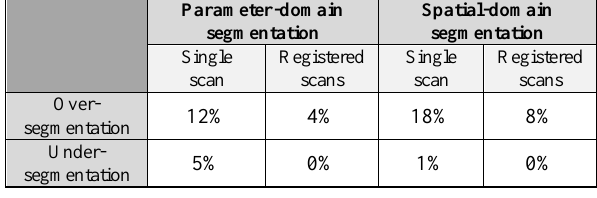
Table 2. Derived quality control measures for the segmented pole-like features from the utilized TLS datasets using the proposed segmentation